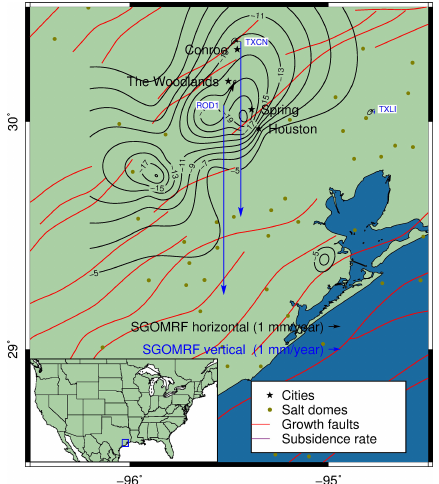
Figure 6. Locations of three CGPS stations and cities within the greater Houston area. Black and blue velocity vectors represent horizontal and vertical velocities with respect to SGOMRF, re- spectively. Red lines are growth faults and yellow dots are salt domes (Garrity and Soller, 2009). Contours lines are subsidence rate from 2005 to 2012 (Kearns et al., 2015).